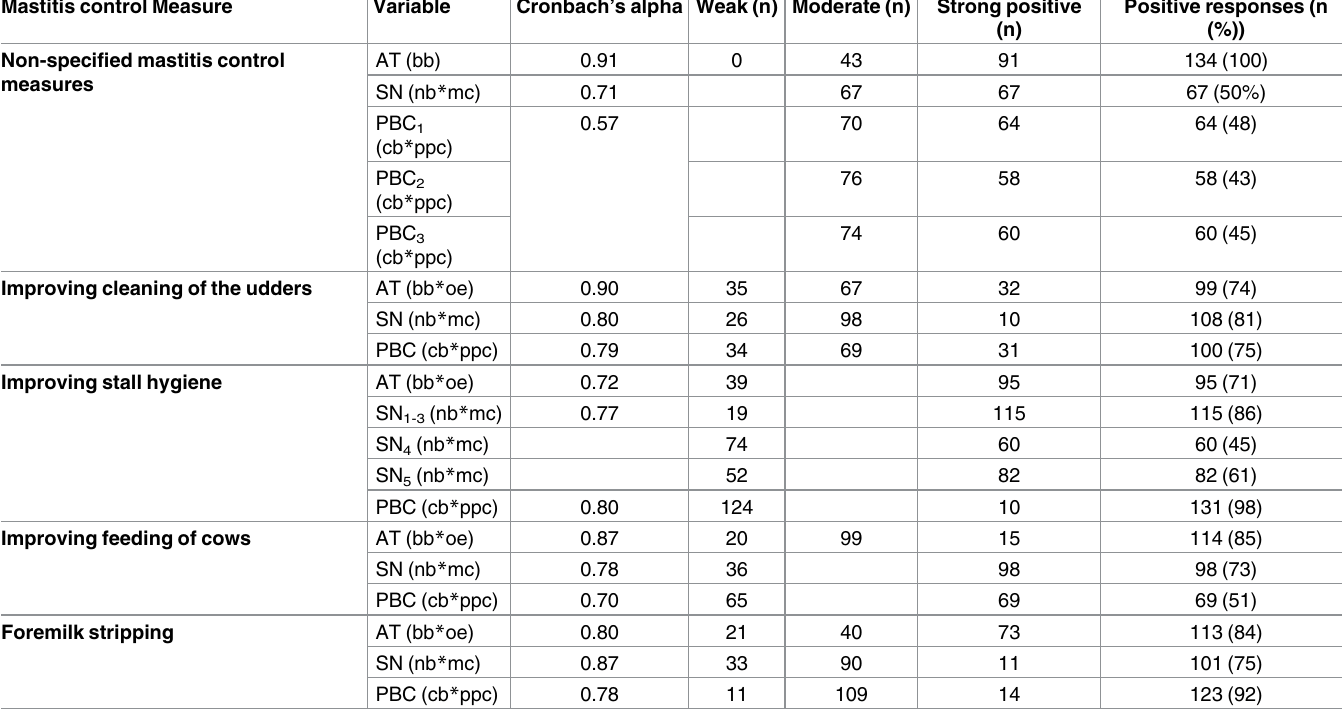
Table 3. Descriptivestatistics of attitude (AT), subjective norms (SN) and perceived behavioral control (PBC) measuredwith respectto the MCM intentions in 134 farmersin North-Western Ethiopia. Mastitis control Measure